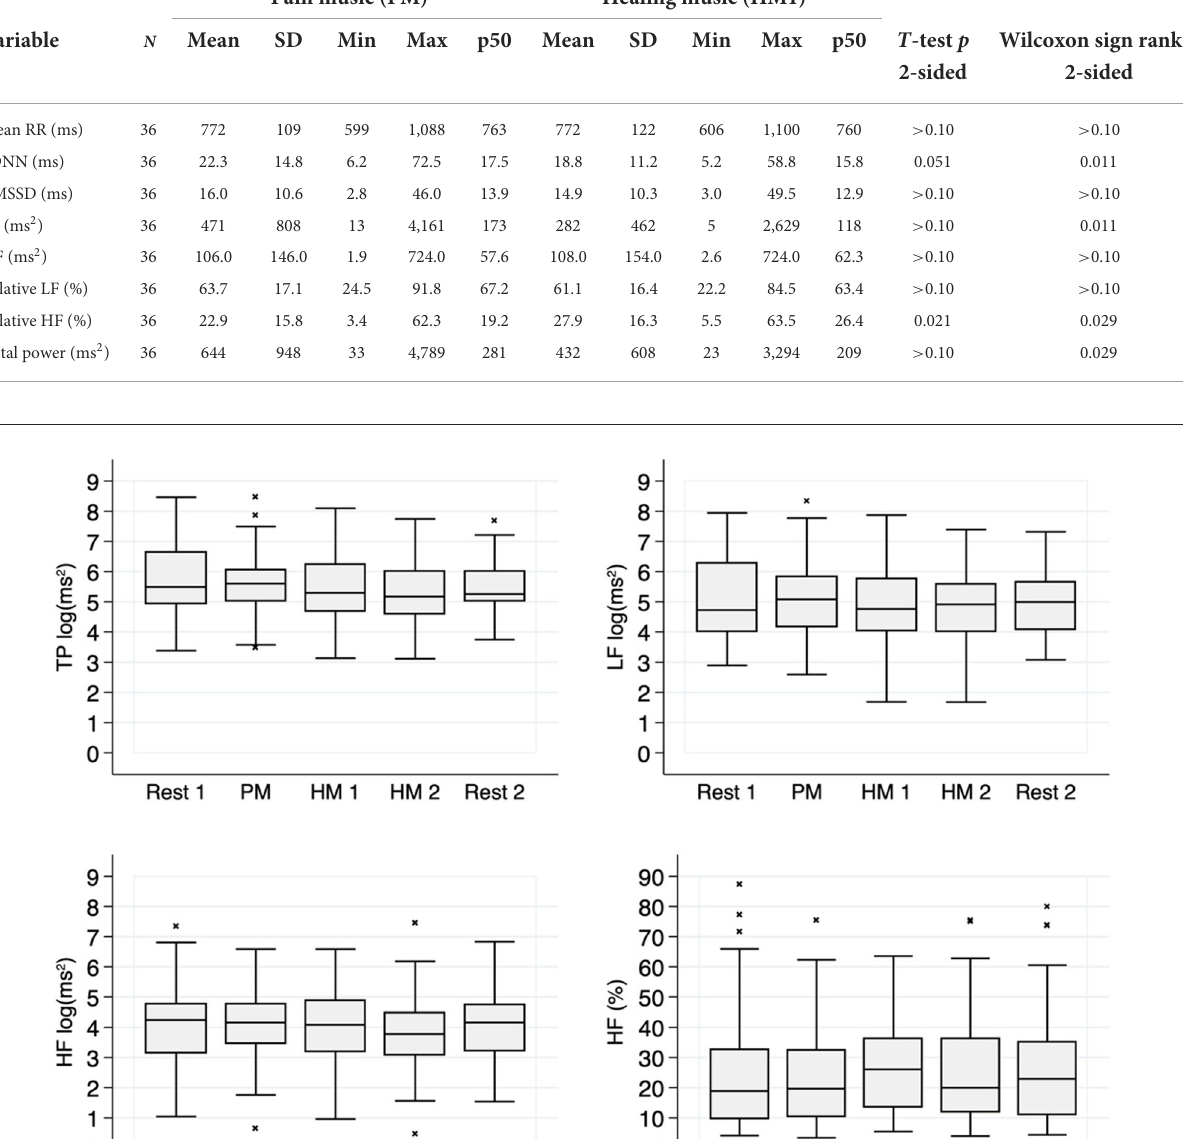
TABLE 4 Comparison of Mean RR and HRV parameters in the phase during Pain Music (PM) and Healing Music (HM1). Pain music (PM) Healing music (HM1)